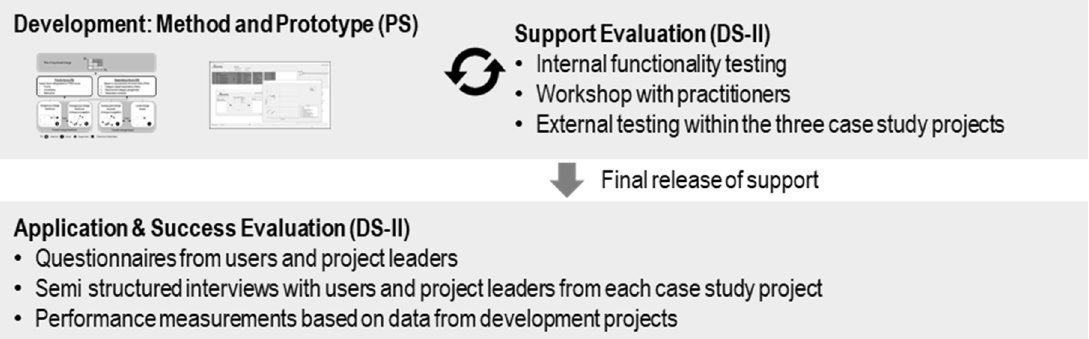
Figure 11. Evaluation approach based on Design Research Methodology (DRM) [47].